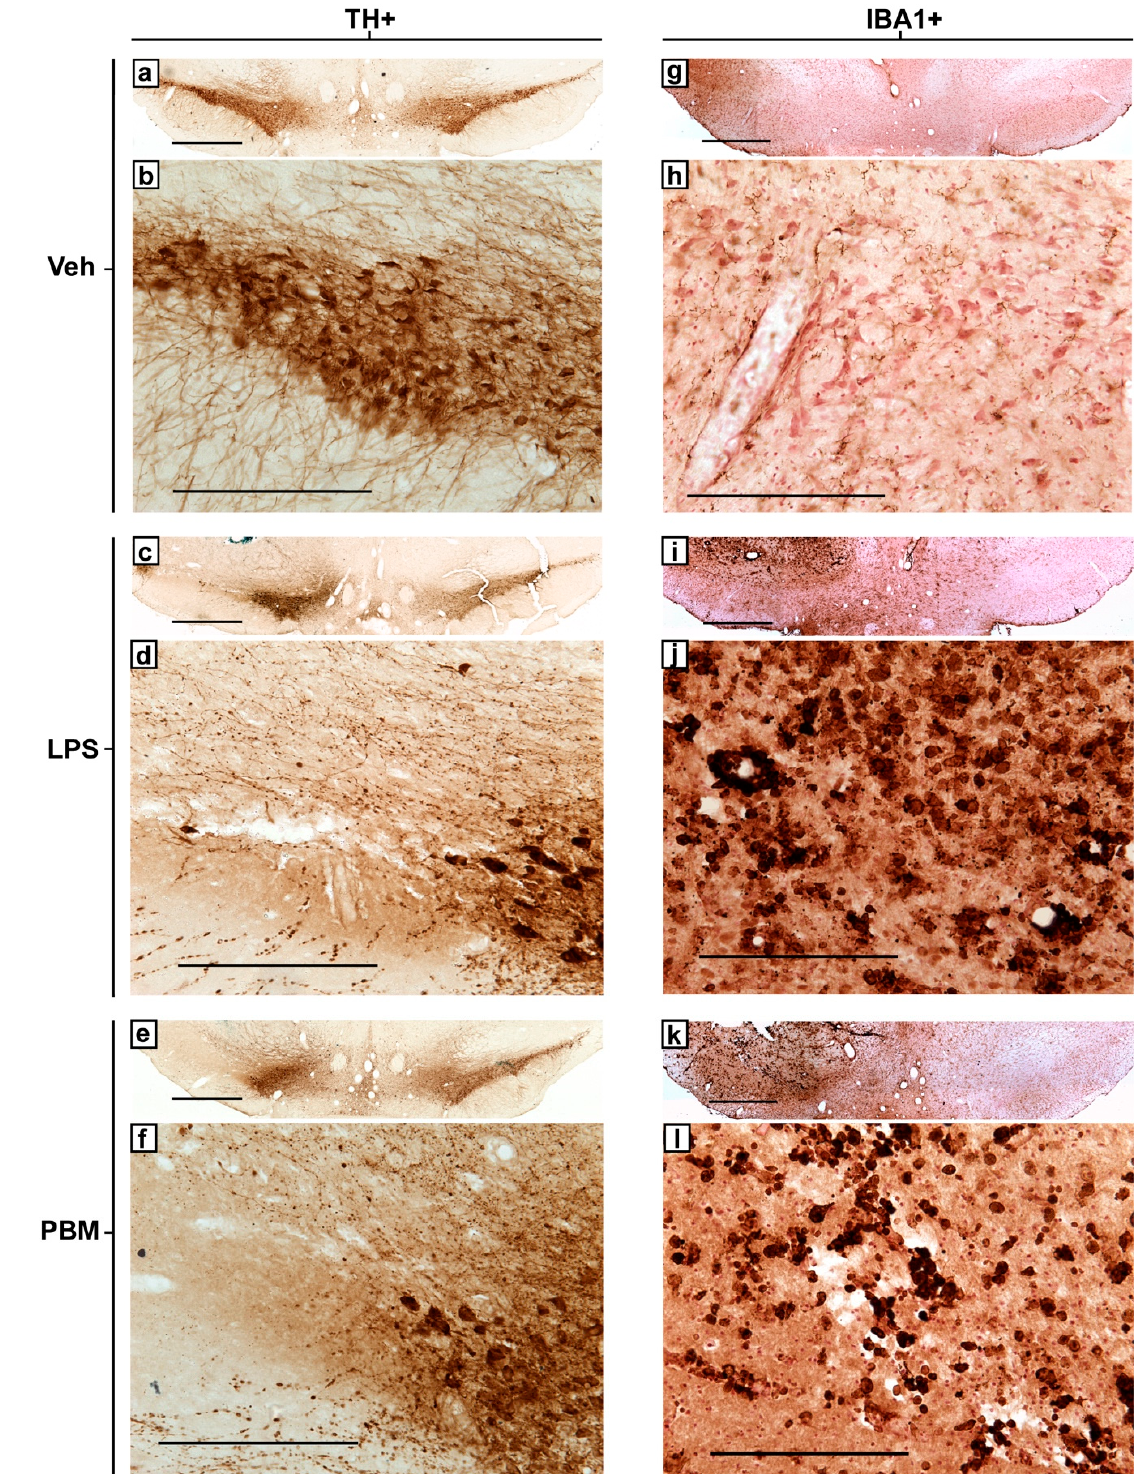
Figure 4. Representative photomicrographs of TH+ and IBA1+ immunostaining in the SNc of 20 µg LPS-treated rats from each experimental group at the same bregma level. ( a ) Bilateral and ( b ) injection-side TH+ staining for a vehicle rat. ( c ) Bilateral and ( d ) injection-side TH+ staining for a representative LPS rat. Large areas of the SNc are without intact cells, and nearby remaining cells increased in their expression of TH. Remaining processes are punctate and dystrophic. ( e ) Bilateral and ( f ) injection-side TH+ staining for a representative PBM rat. ( g ) Bilateral and ( h ) injection-side IBA1+ staining for a vehicle rat. Cells were ramified or rod-like in morphology with long, distinguished processes. Brown staining: immunostaining precipitate. Pink-red staining: neutral red